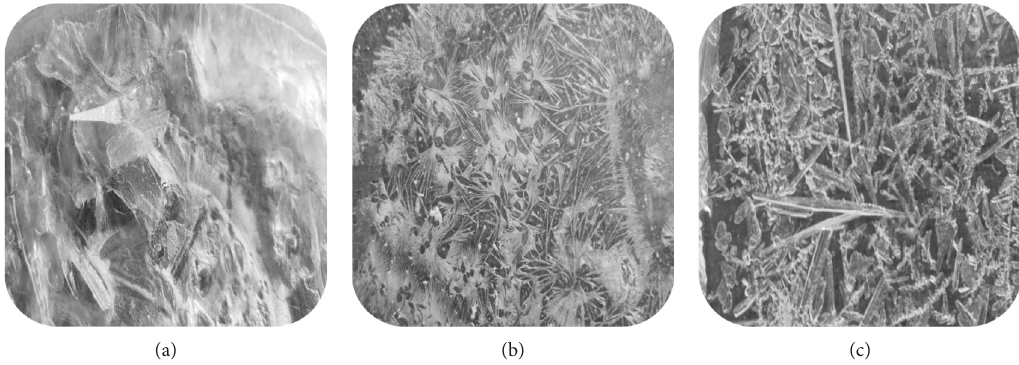
Figure 9: Optical microscopy 10x by the (a) conduction heating (KC), (b) microwave (KMO), and (c) ultrasound (KUS) samples.